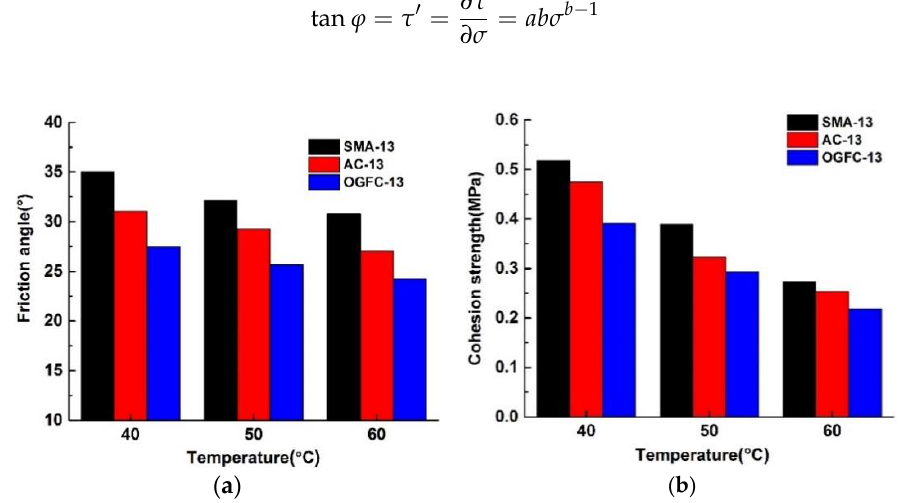
Figure 11. Cohesion strength and friction angle by linear failure envelope. ( a ) The friction angle by linear failure envelope; ( b ) The cohesion strength by linear failure envelope.